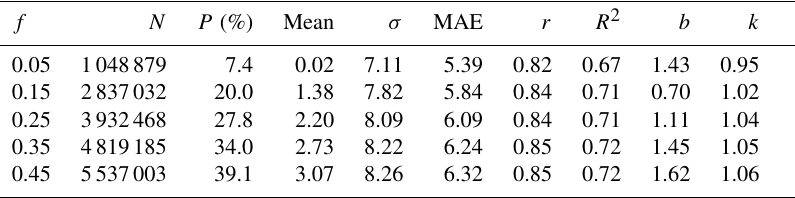
Table 3. Effect of cloud fraction threshold on the comparison between SSMIS and version 4.0 OMI TCWV for July 2006.